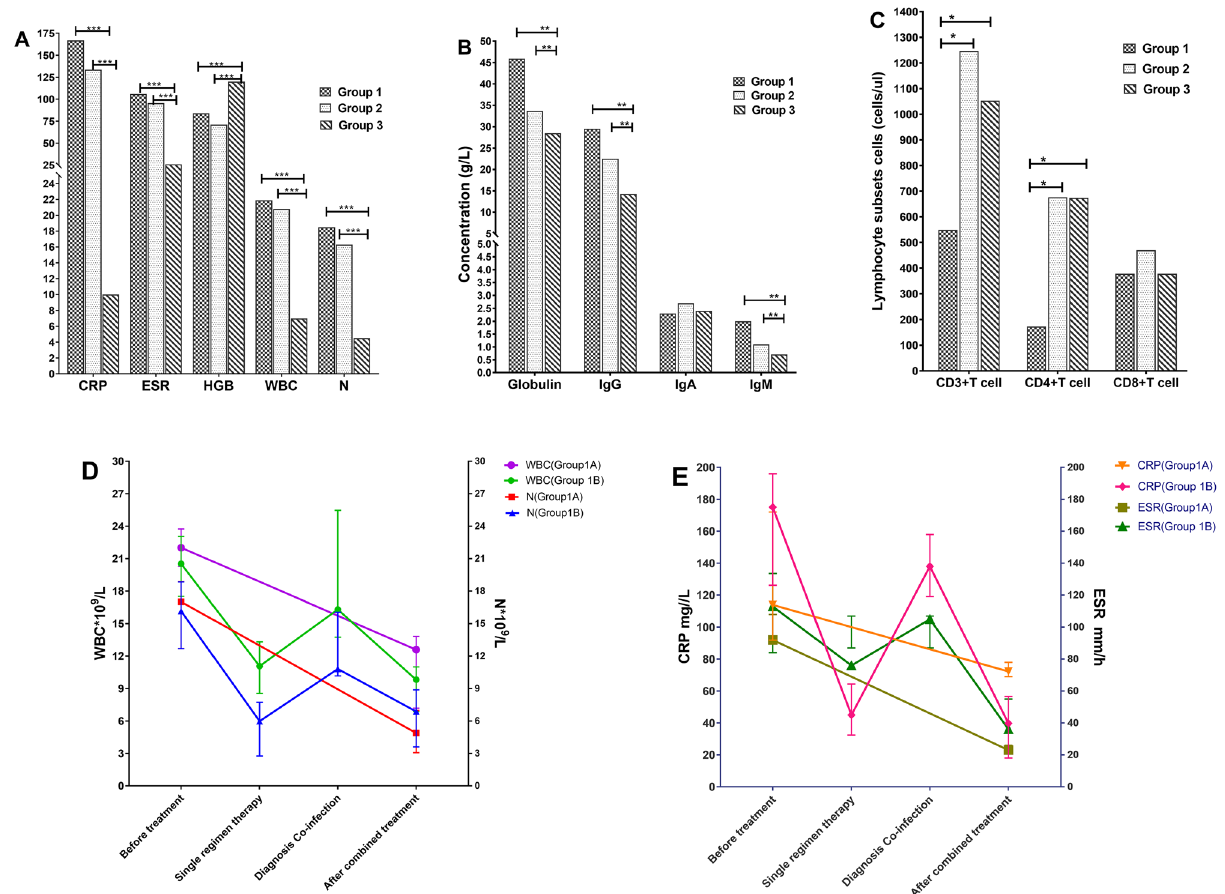
Figure 1. Comparison of biochemical indexes between groups. ( A ) White blood cell (WBC), neutrophil (N) counts, erythrocyte sedimentation rate (ESR), and C reactive protein (CRP) were significantly increased in Groups 1 and 2 compared with Group 3 ( P < 0.001). ( B ) Globulin, IgG, and IgM in Group 1 were higher than normal reference values and higher than Groups 2 and 3 ( P < 0.01). ( C ) CD4 + T and CD3 + T-lymphocyte counts in Group 1 were lower than normal reference values and lower than Groups 2, 3, and 4 ( P < 0.01). ( D , E ) After combined treatment, all parameters in patients were